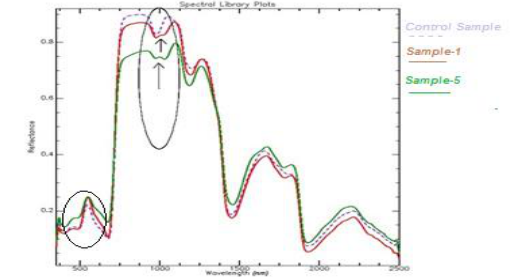
Figure 4. The spectral profile of Eucalyptus leaves for control and polluted samples 1, 5, 8